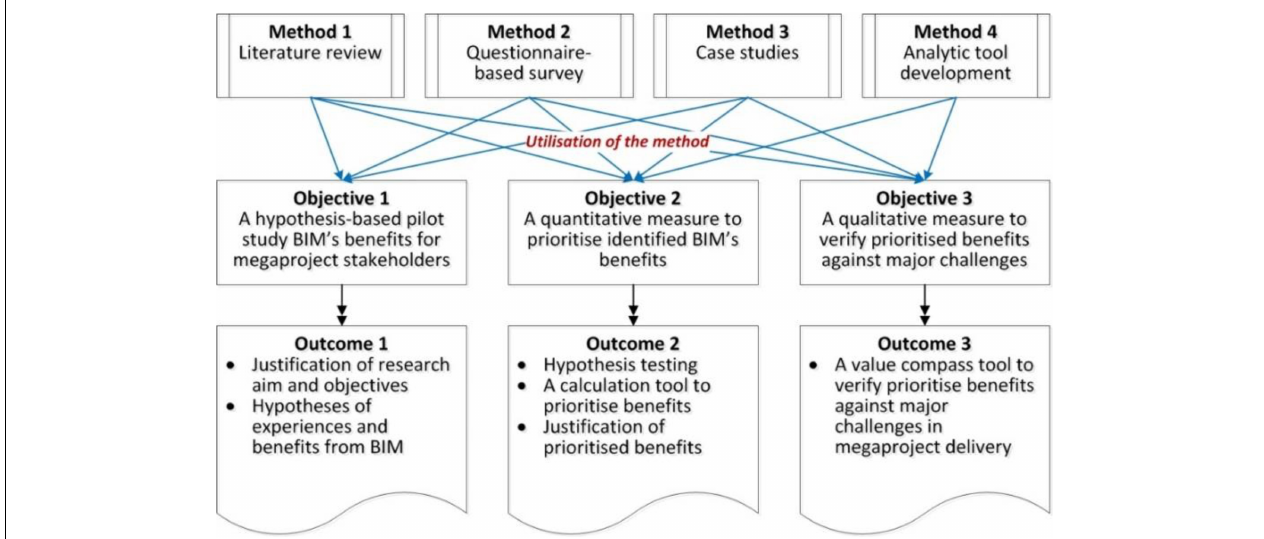
FIGURE 1 | Methodology established for research and development.